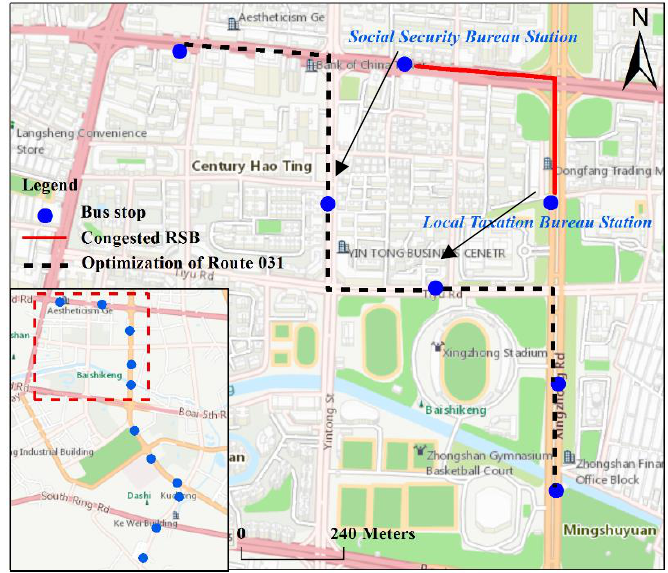
Figure 10. The optimization of route 031. The inset shows the spatial distribution of route 031